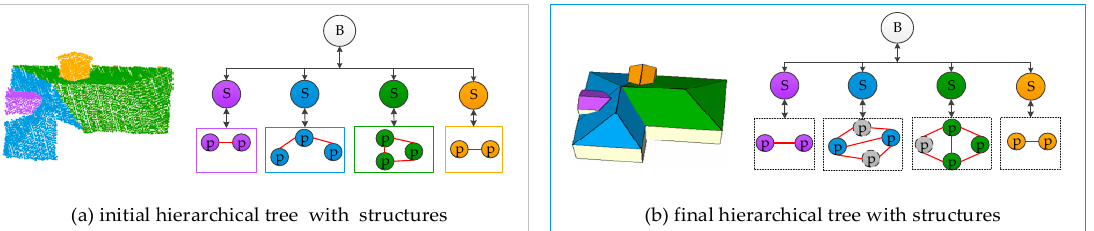
Figure 8. Overview of the model refinement. ( a ) Structures before refinement; ( b ) the final structured model and the refined hierarchical structure tree. Each color represents an individual structure.